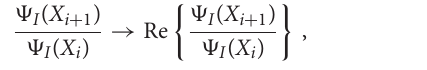
and the green band represents the final result including the uncertainty coming from the fitting